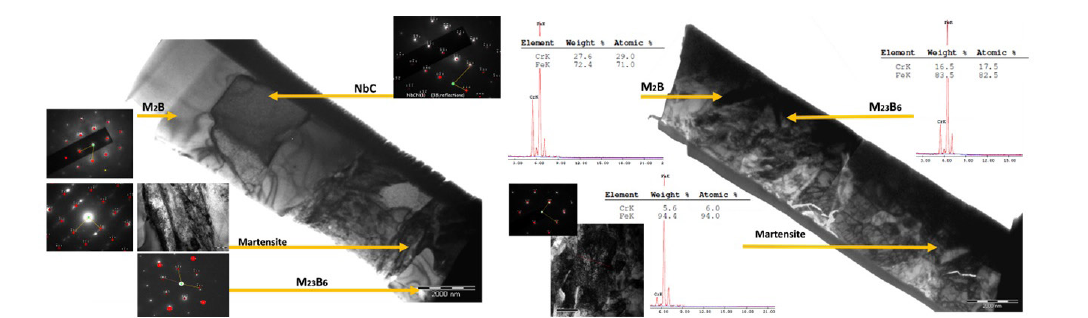
Figure 6. TEM images, electron diffraction patterns and EDS of the phases for AW and